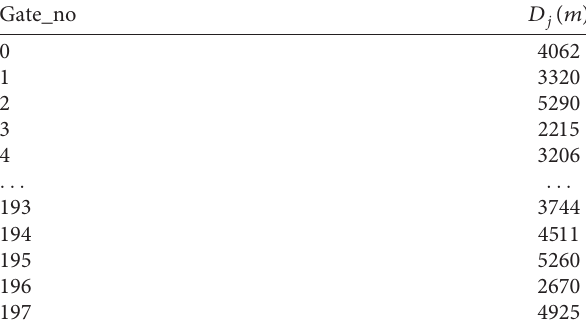
Table 10: Average distance from the landing runway to the gate j